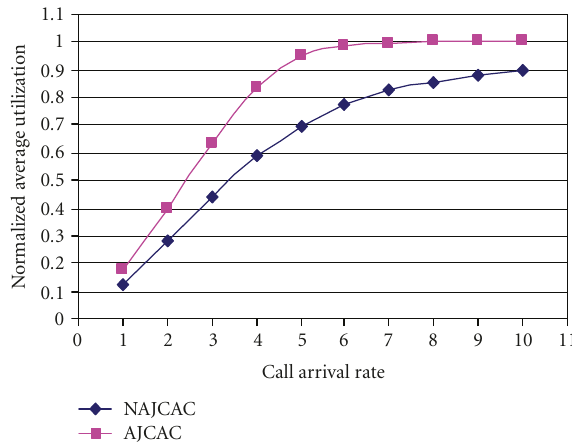
Figure 11: Impact of varying the call arrival rate on the normalized average system